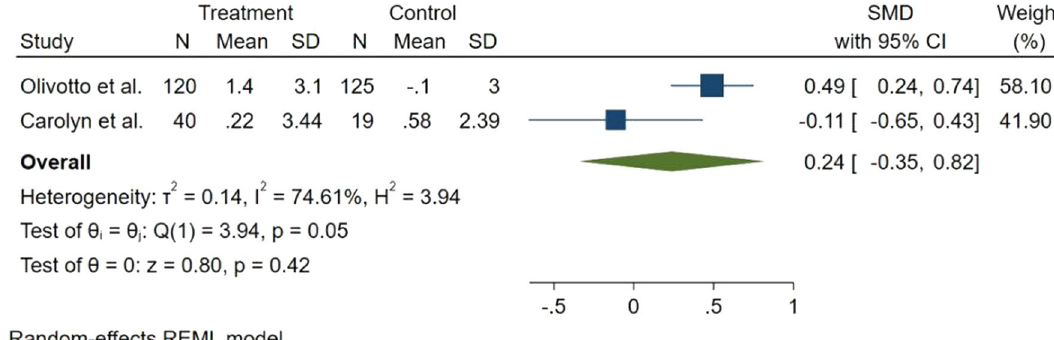
Fig. 5 Forest plot for peak oxygen uptake (PVO 2